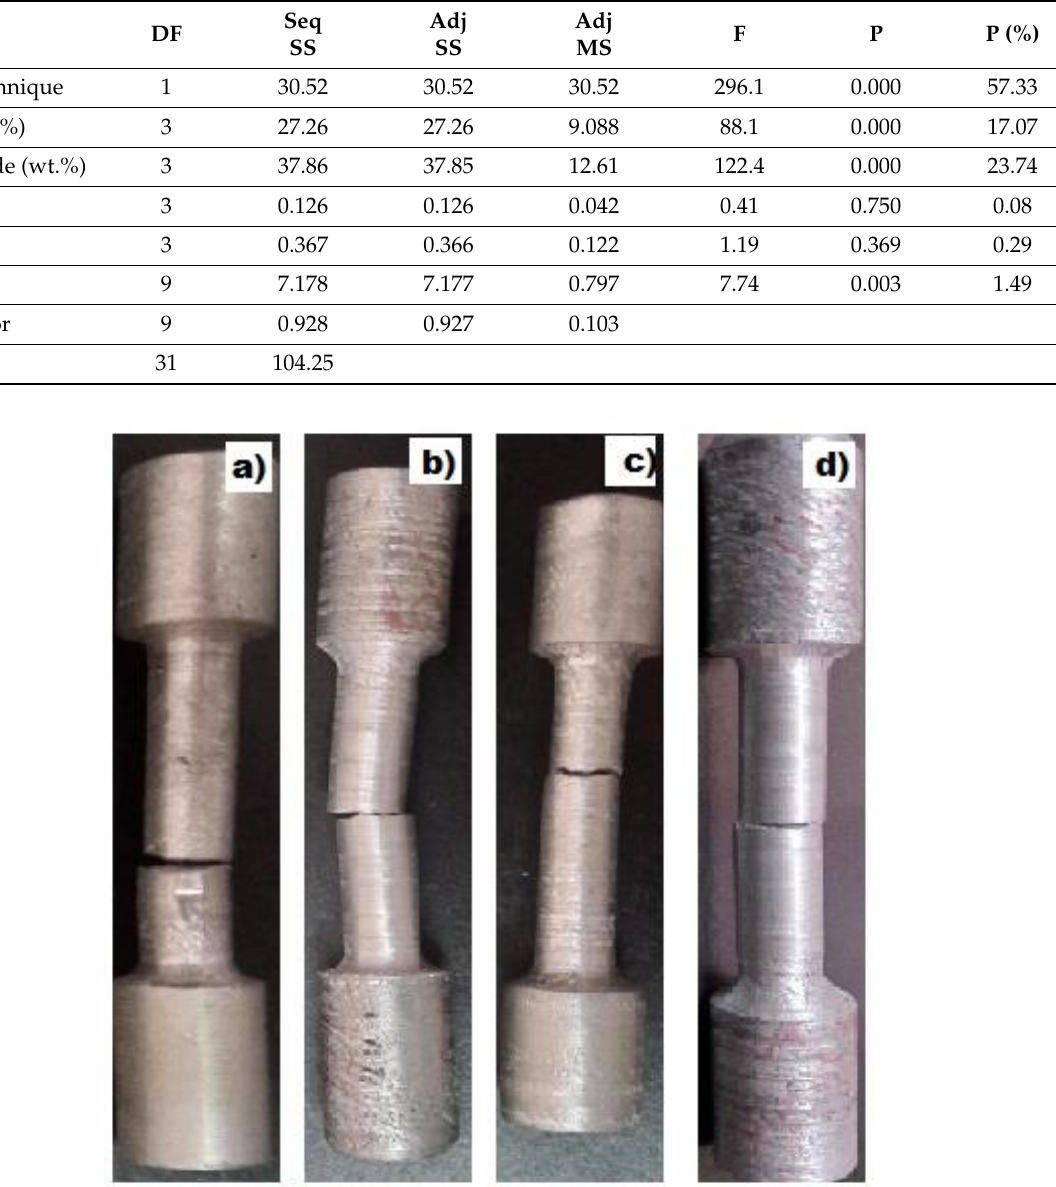
Figure 24a–c shows the SEM images of the fracture surface of Si-Al-ZrO 2 (5, 10,